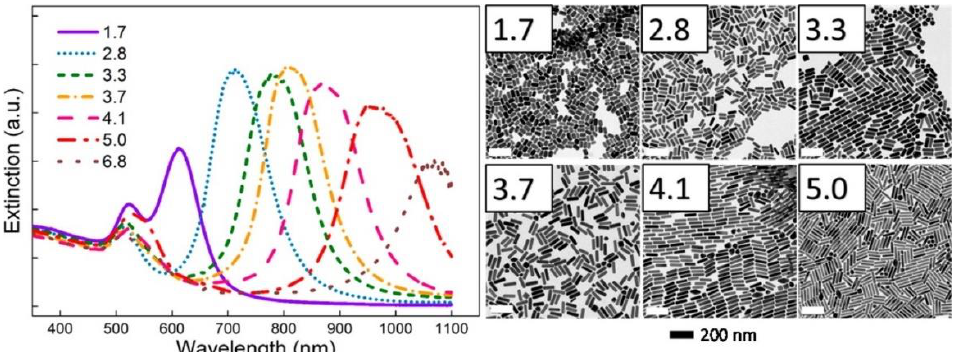
Figure 15. Another application of UV-Vis spectroscopy to characterize the dependence of plasmon resonance sensitivity on the geometry and morphology of the plasmonic system. UV-vis spectra of gold nanorods with aspect ratios varying between 1.7 to 6.8 along with the TEM images corresponding to each are shown. As is observed, the plasmon resonance of a gold nanorod can be tuned across the solar spectrum by controlling its nanogeometry. This has potential in the fabrication of composite, panchromatic plasmonic systems that ideally provide for broad and uniform absorption properties across the visible portion of the solar spectrum [178]. Reprinted with permission from Ref [178] Copyright American Chemical Society (2015).